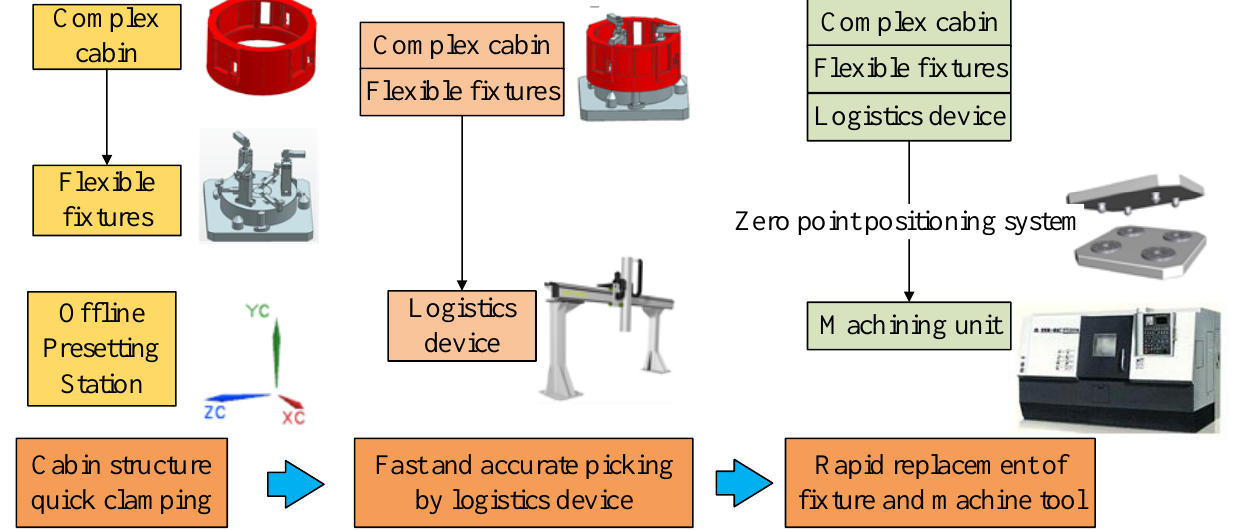
Figure 12. Implementation scheme diagram of rapid clamping and alignment of the machine for complex cabin section. complex cabin